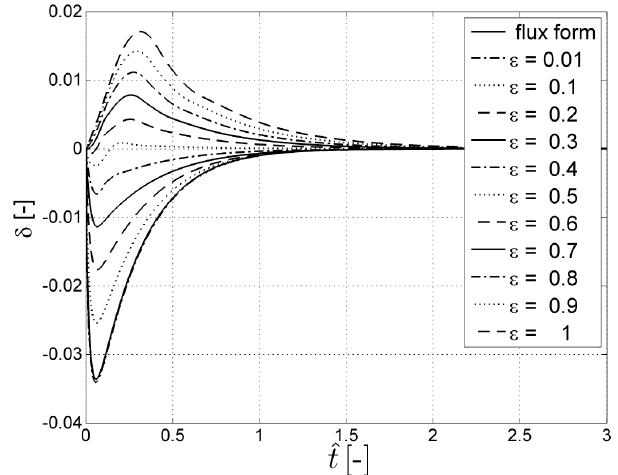
Figure 6. Degradation case: variation in time of the dimensionless concavity parameter δ in the case of the flux formulation and in the cases of the entrainment formulation for di ff erent values of ε ranging from 0.01 to 1. The result for the flux form overlaps with the result for the entrainment form with ε = 0 . 01. Note the reversal in transient behavior as ε increases beyond about 0.5.